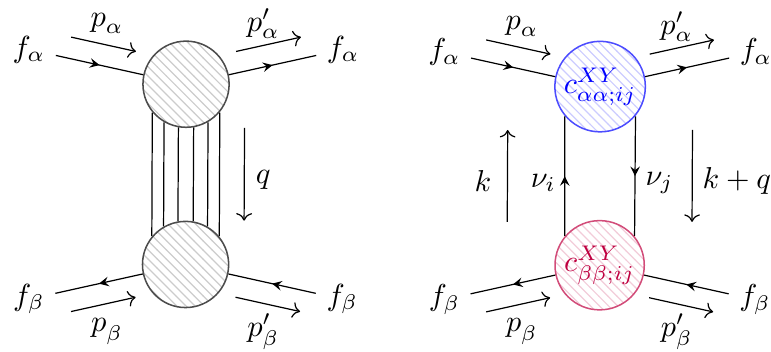
Figure 1 . Left: long-range force mediated between particles f (cid:11) and f (cid:12) by virtual particles carrying the momentum exchange q = p mass-eigenstate neutrinos between fermions f (cid:11) and f (cid:12) . The interaction vertices are four-fermion interactions with coe(cid:14)cients c XY to the chirality of the fermion and neutrino